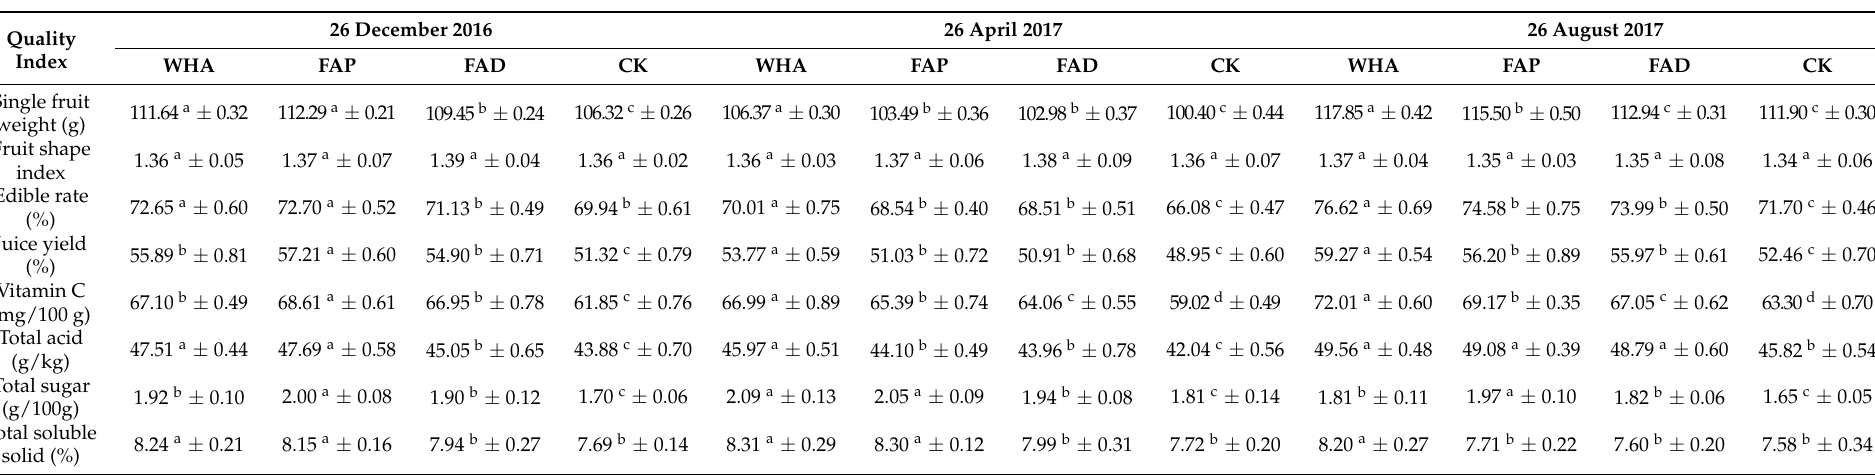
Table 1. Effects of humic/fulvic acid fertilizers on quality of lemon